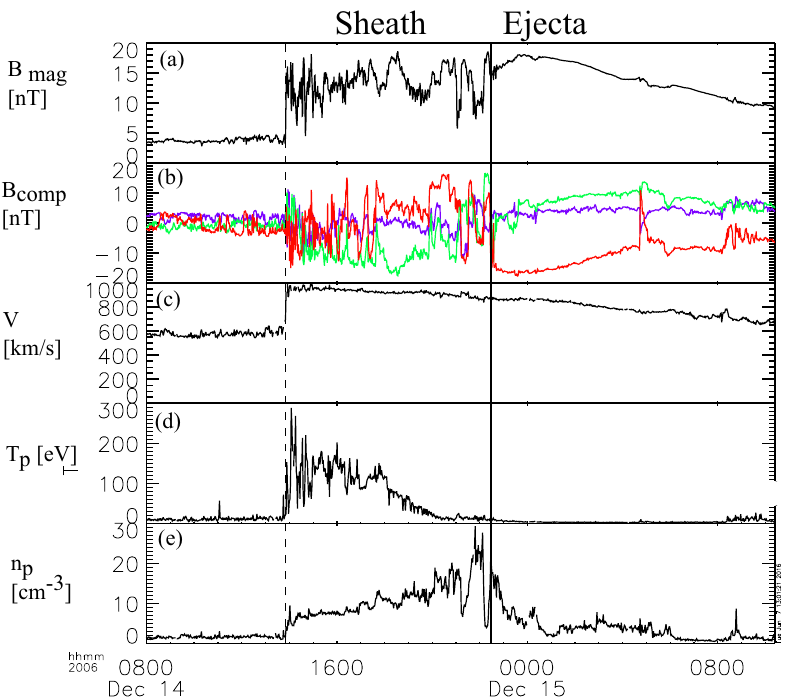
Fig. 17 An example of a sheath region between a forward shock and an MC. The panels show from top to bottom: a the magnetic field magnitude, b components of the magnetic field in GSE coordinates ( B X : purple, B Y : green, B Z : red), solar wind c speed, d proton temperature, and e proton density. The dashed line shows the shock and the solid line the leading edge of the ICME. The measurements are from the ACE spacecraft. Data have been obtained from the ACE Data Center